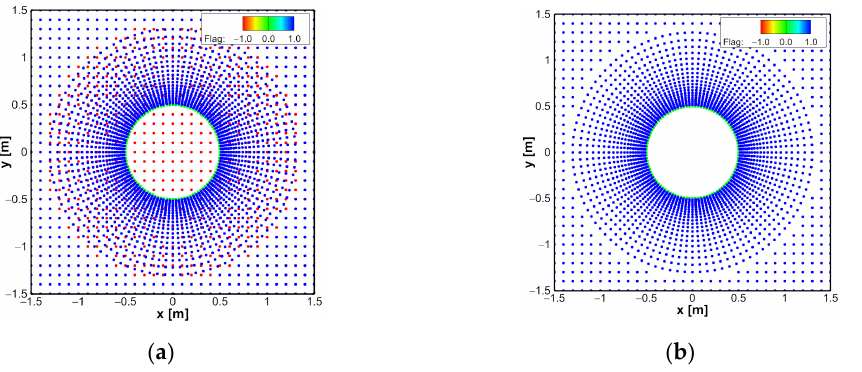
Figure 7. Distribution of the computational points near a body ( a ) with and ( b ) without inactive points (flag values of −1, 0, and 1 indicate inactive, fluid, and boundary points, respectively). Figure 8 shows the contour maps of the velocity, pressure, and vorticity magnitude in the x and y directions when Re = 40 at t = 400 s . Symmetric flow patterns against the y centerline of the cylinder were well reconstructed . The velocity vector fields and stream- lines around the cylinder are depicted in Figure 9. A pair of attached symmetric vortices is observed, and the attachment length of the vortex is approximately 2.3, which is in the range reported by other studies [34,35].